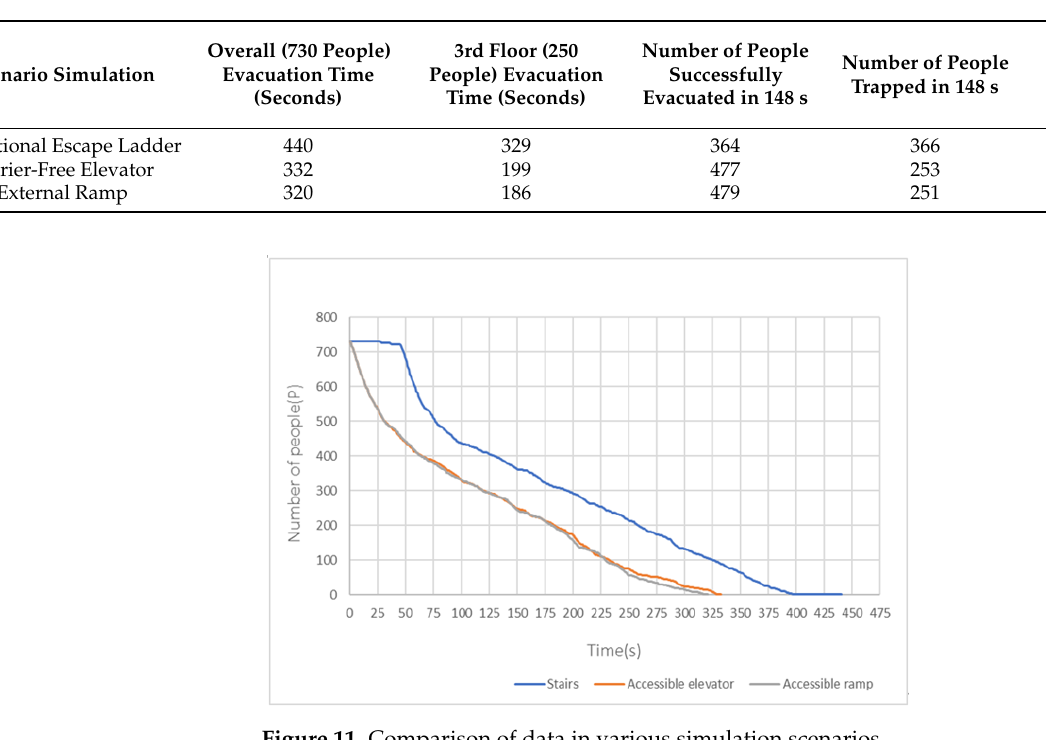
Table 5. Comparison of data in various simulation scenario.